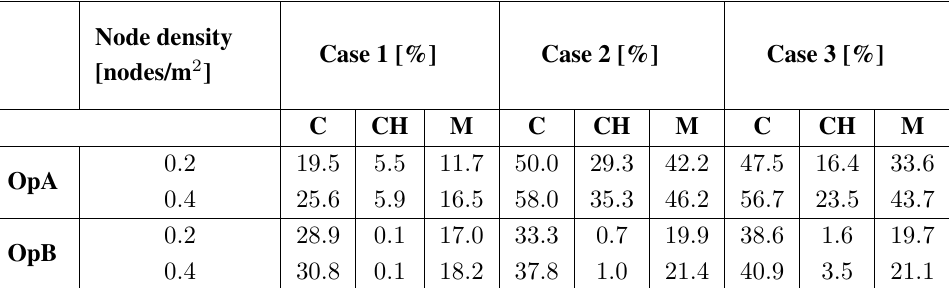
Table 4. Percentage values of energy conservation using the framework, for OpA and OpB, in cases UC-UE, NUC-UE and UC-NUE, comparisons C, CH and M, for a node density of 0 : 2 and 0 : 4 nodes/m 2 .